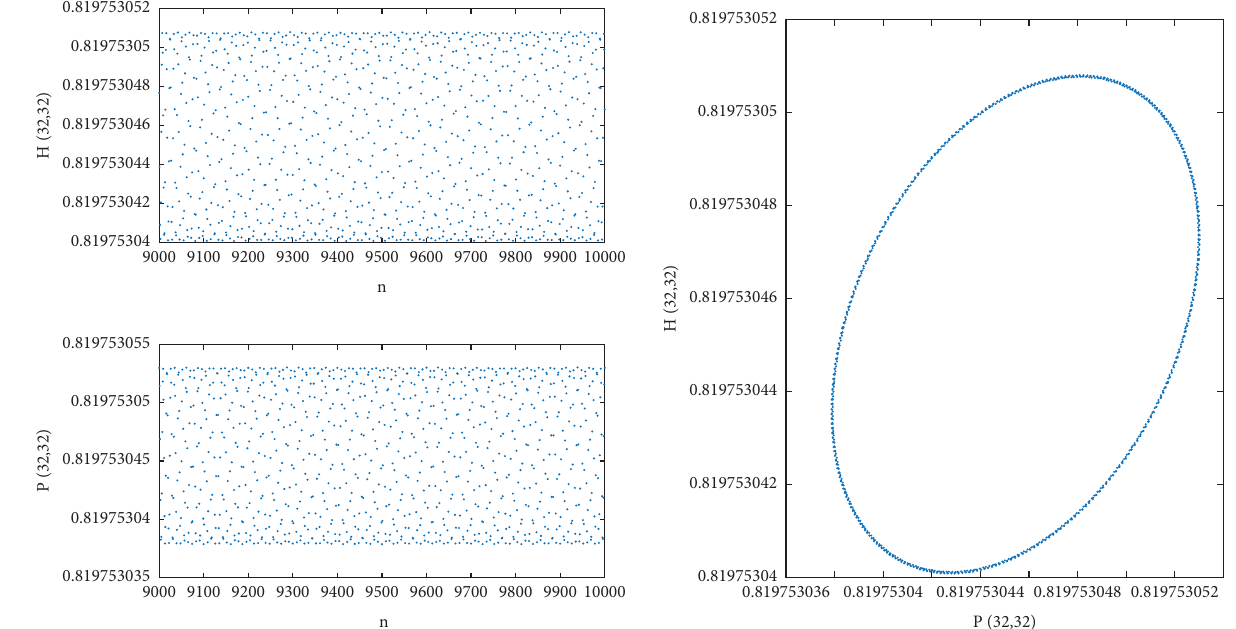
, d ) � ( 0 . 2 , 0 . 166667 ) falls at the junction of regions III and IV in Figure 9(b), 1 2